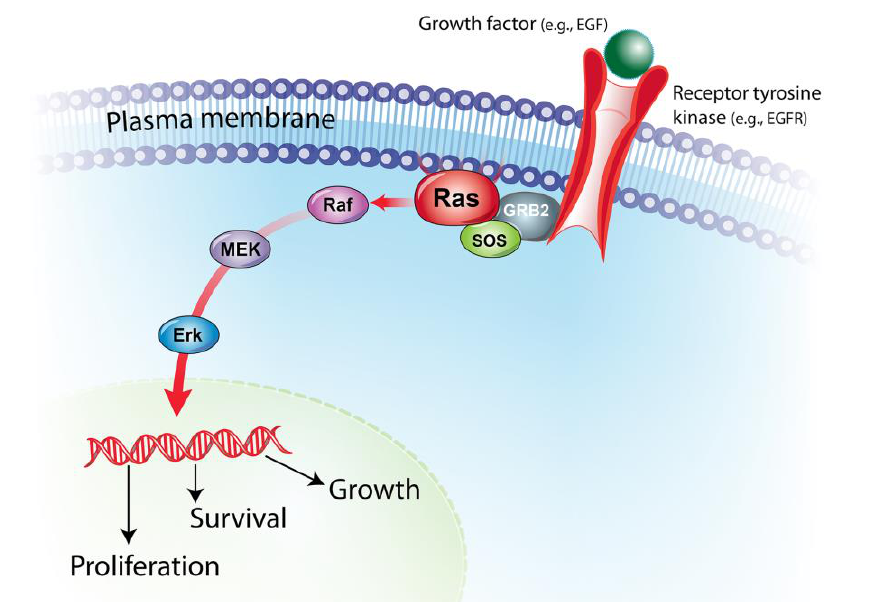
Figure 1. Mitogen-activated protein kinase (MAPK)/extracellular signal-regulated kinase (ERK) pathway. The MAPK/ERK signaling pathway is activated by many different extracellular signals such as binding of growth factors (e.g., EGF) to its receptors (e.g., EGFR). Activated receptor tyrosine kinase phosphorylates and activates RAS family proteins through GRB2-SOS adaptor protein complex. Activated RAS protein, in turn, activates the serine/threonine kinase function of RAF proteins. RAF phosphorylates MEK, which phosphorylates and activates ERK, initiating the signal transduction of many genes involved in various cellular